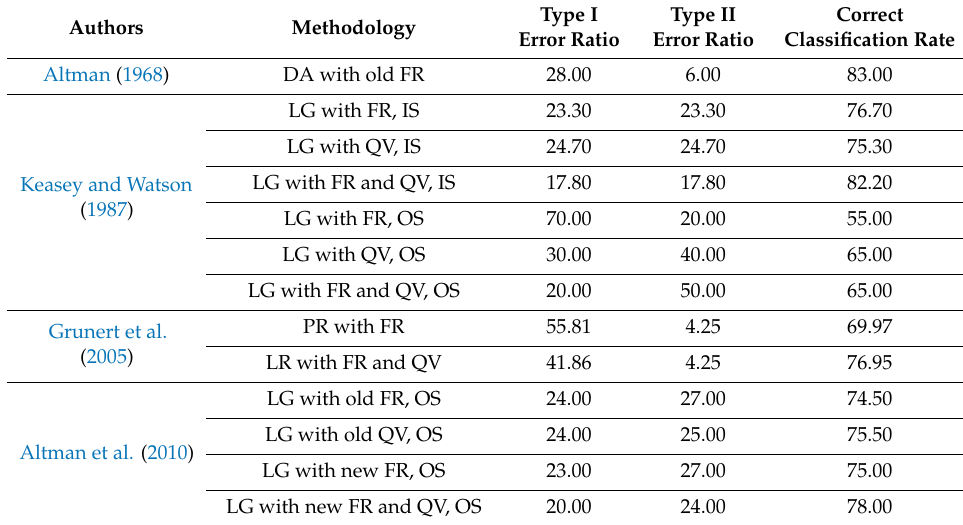
Table 8. Classification Errors in Previous